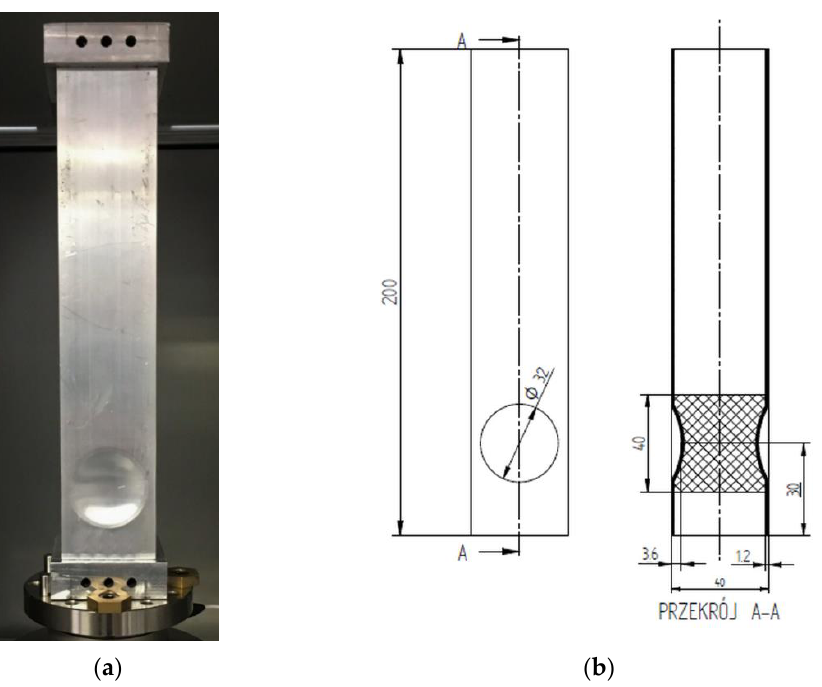
Figure 2. ( a ) Physical view of the specimen attached to the test table; ( b ) The technical drawing with dimensions of the C32 model filled with 40 mm length foam.